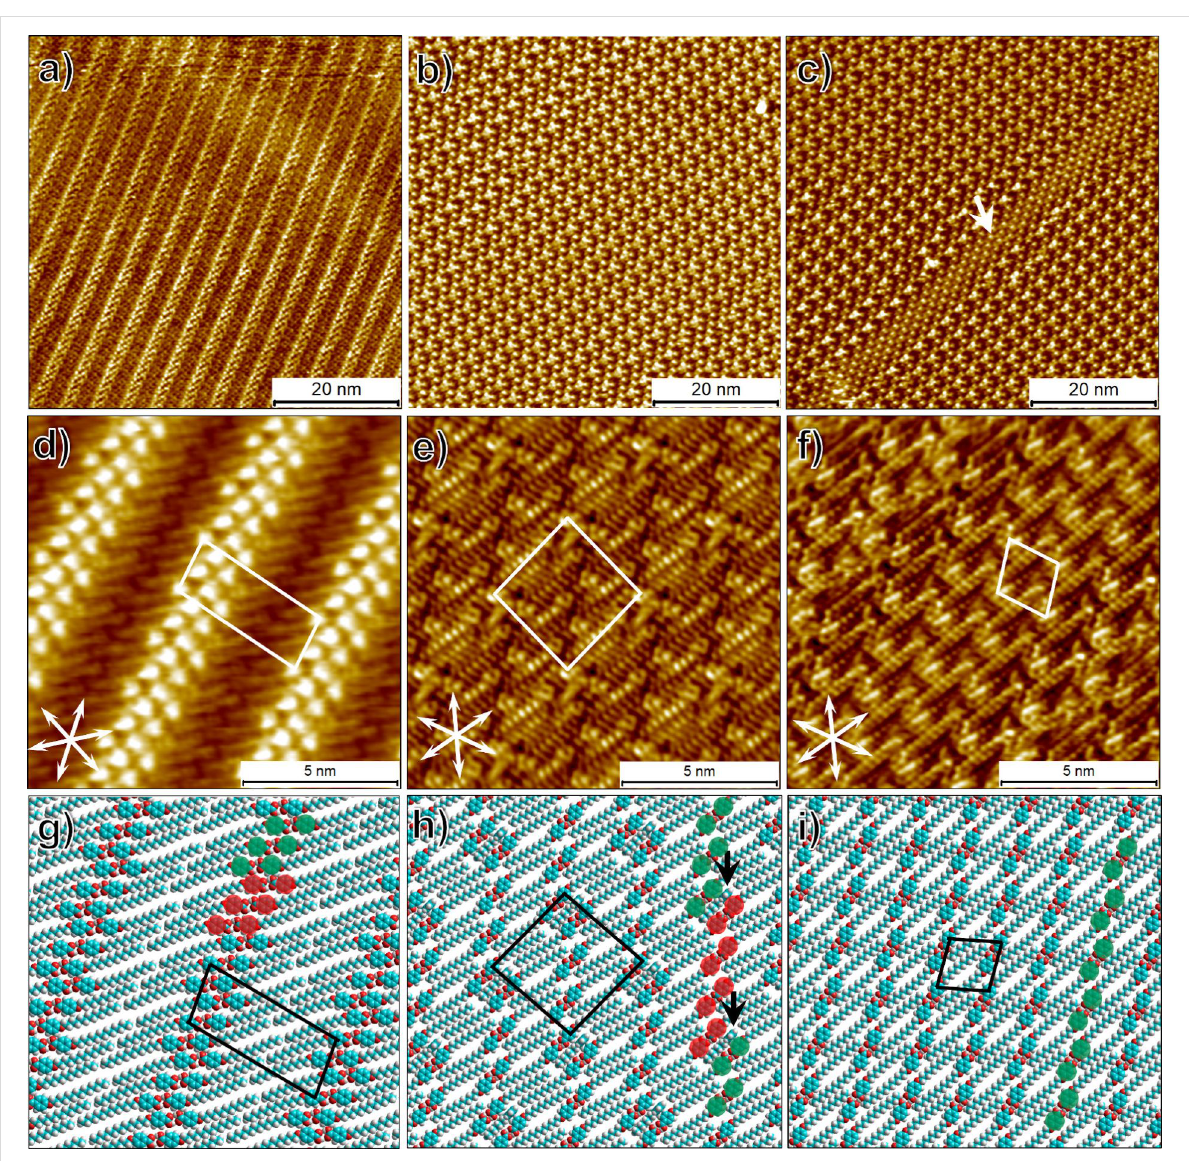
Figure 2: STM images of concentration dependent polymorphs of BA-OC 14 formed at the 1-phenyloctane–HOPG interface. (a,b,c) Large scale STM images of polymorph A, B and C, respectively. (d,e,f) High-resolution STM images of polymorph A, B and C, respectively. The white double-headed arrows at the lower left corner of the image represent the three symmetry axes of the graphite lattice. (g,h,i) Molecular models for polymorph A, B and C, respectively. Imaging conditions: (a) I set = 70 pA, V bias = − 1.55 V; (b,c) I set = 140 pA, V bias = 0.55 V; (d) I set = 50 pA, V = − 1.85 V; (e,f) I set = 140 pA, V bias = 0.55 V. For additional data, see Figures S1 and S2 in Supporting Information File 1.